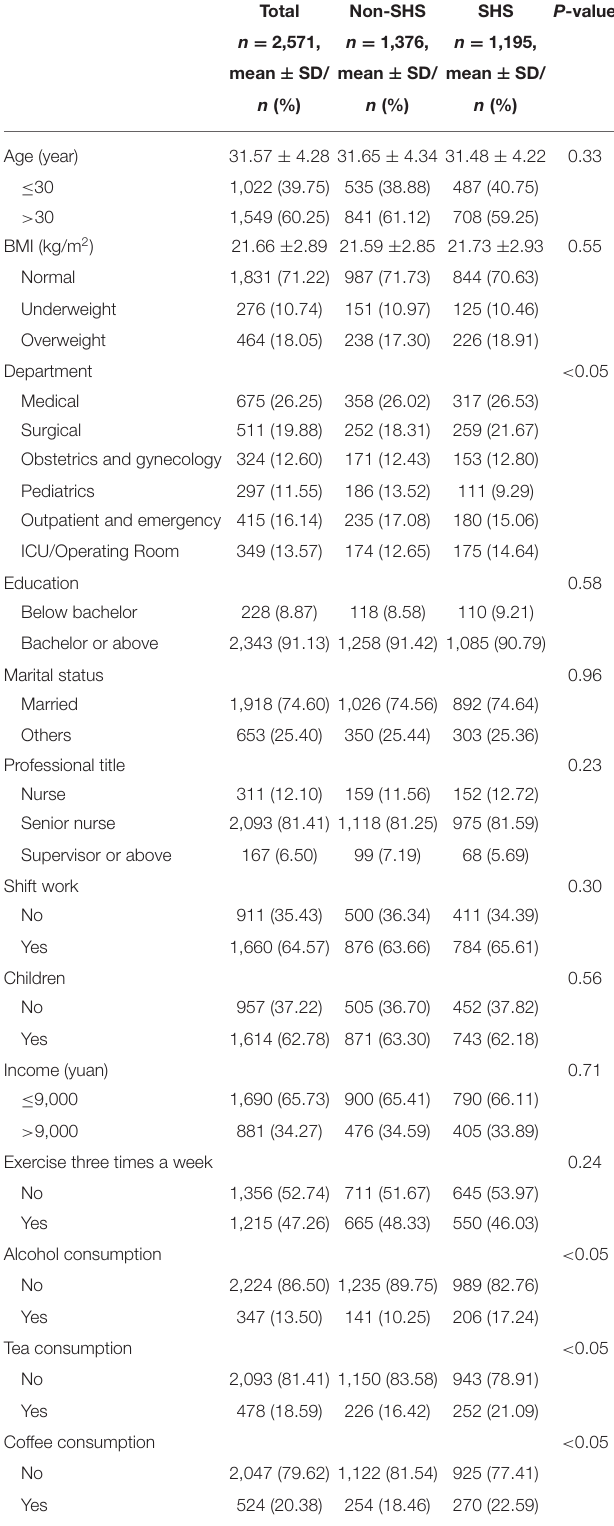
TABLE 1 | Basic characteristics of the participants according to passive smoking exposure ( n =